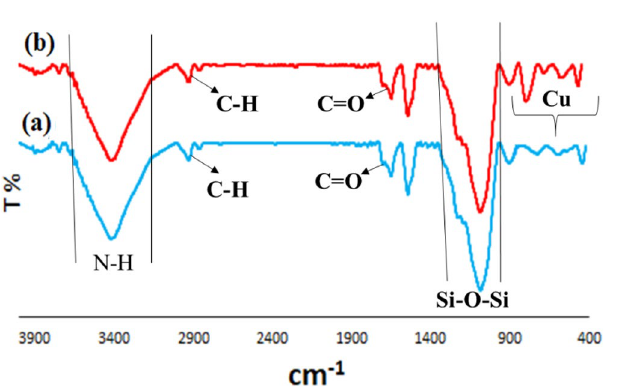
Figure 1. Schematic structure of the Cu@APS-TDU-PMO nanoreactor ( 1 ) for the three-component condensation of aldehydes ( 2a–i ), malononitrile ( 3 ), and sodium azide ( 4 ).